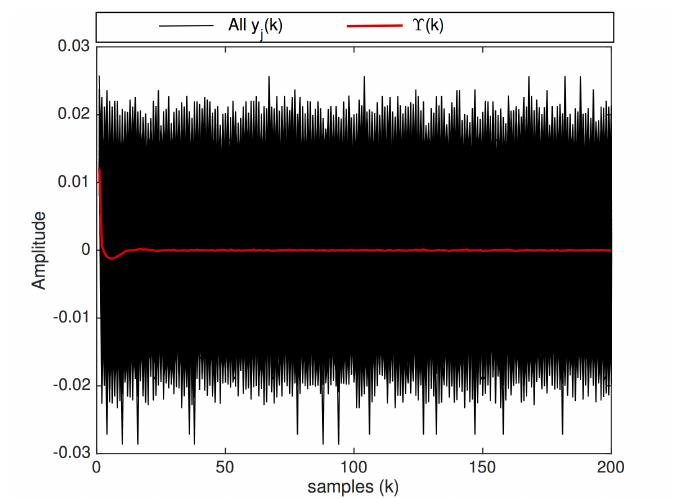
Figure 9. The impulse response Υ ( k ) (in red) produced by the NII technique after the integration of a set of signals y j ( k ) (shown overlapped in